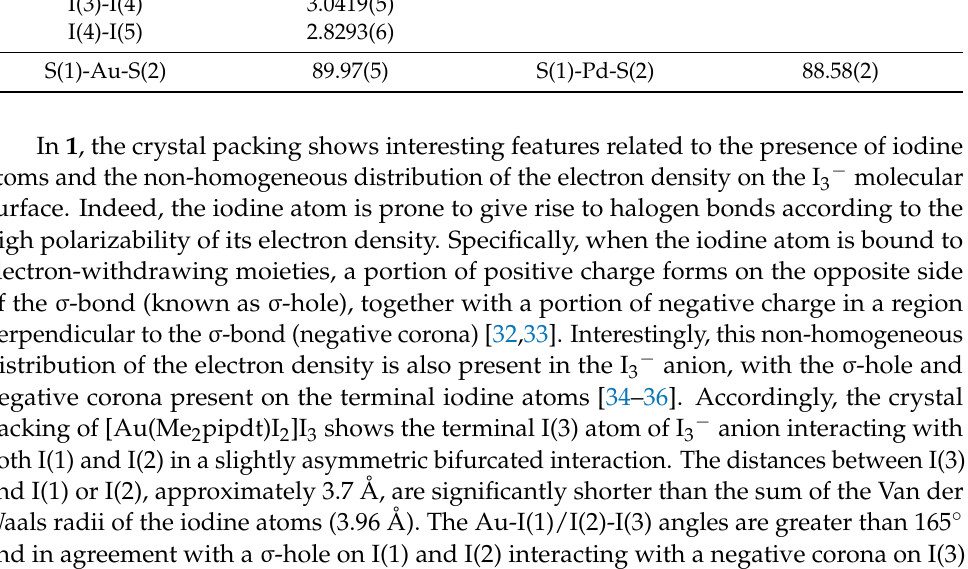
Figure 6. Depiction of the molecular planes used to calculate the dihedral angle between the S,S-chelate ligands ( a ) and between the thioamido groups ( b ). See also Tables S2 and S3.